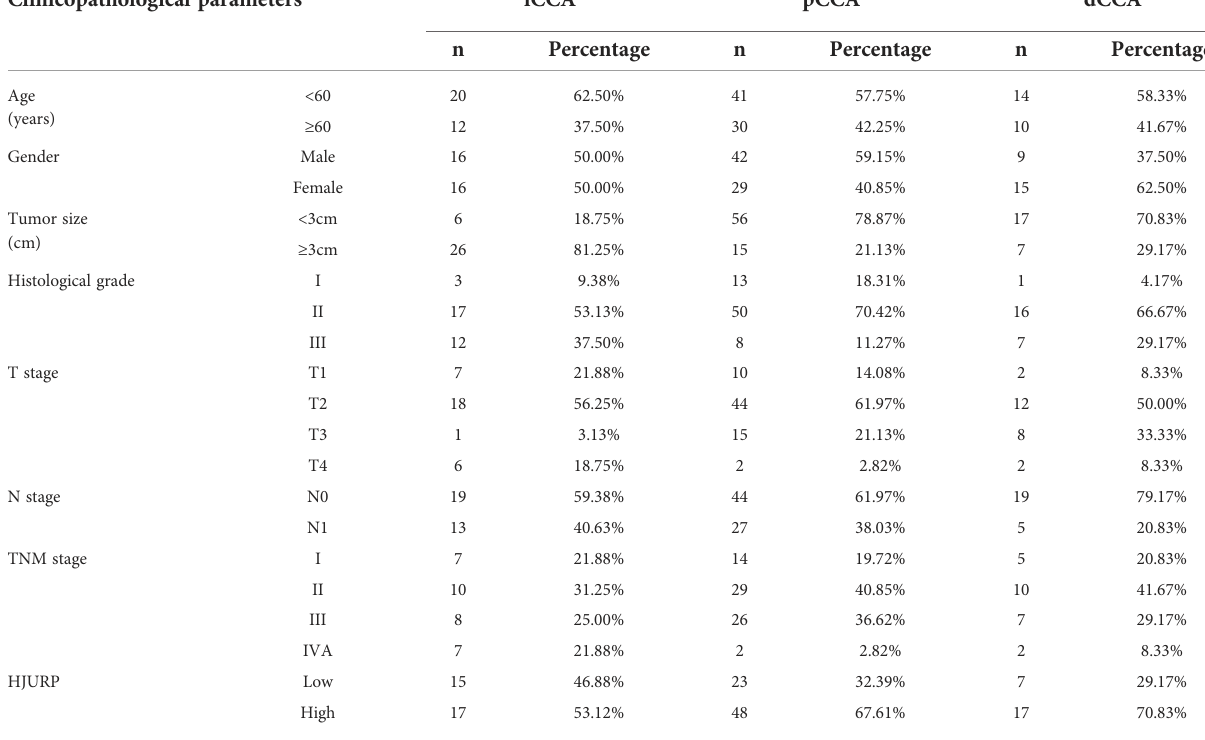
TABLE 1 Basic information of the CCA